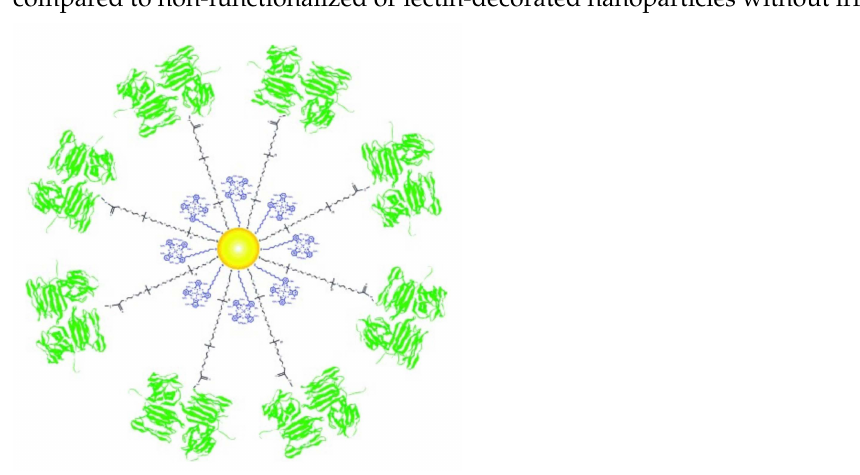
Scheme 5. Schematic illustration of the nanomedicine based on PEGylated-Jacalin and PEGylated- dimeric ZnPcs, which were both covalently bonded to gold nanoparticles (T antigen-specific lectin: green; Pc: blue; thiol-functionalized PEG: black; gold NP: yellow). Reprinted with permission from ref [125]. Copyright 2012 Wiley-VCH Verlag GmbH & Co. KGaA,